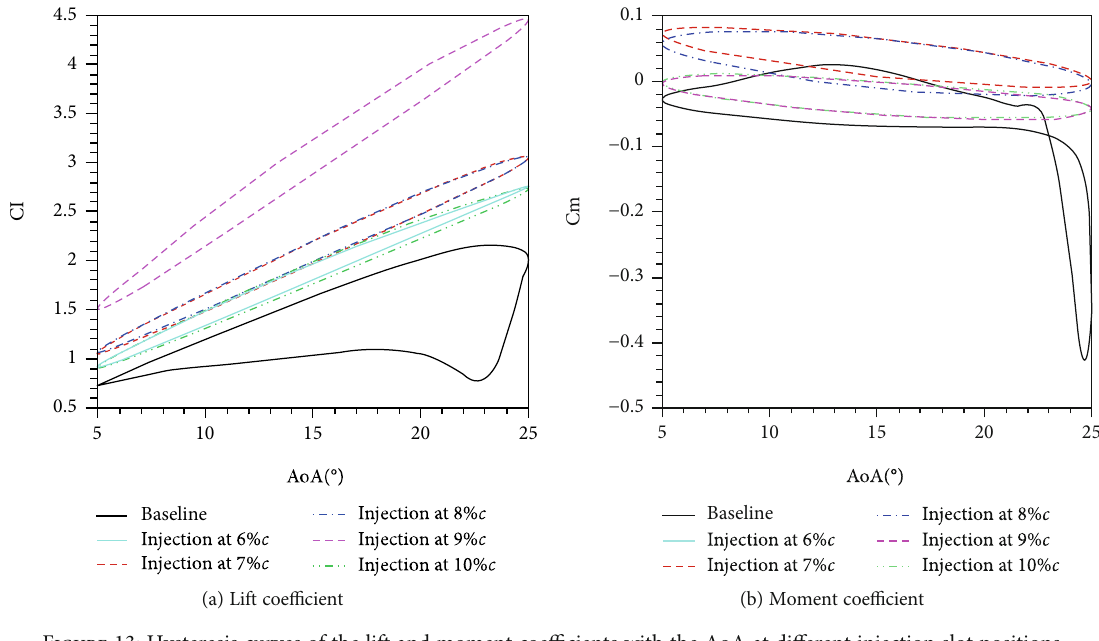
Figure 13: Hysteresis curves of the lift and moment coe ffi cients with the AoA at di ff erent injection slot positions.